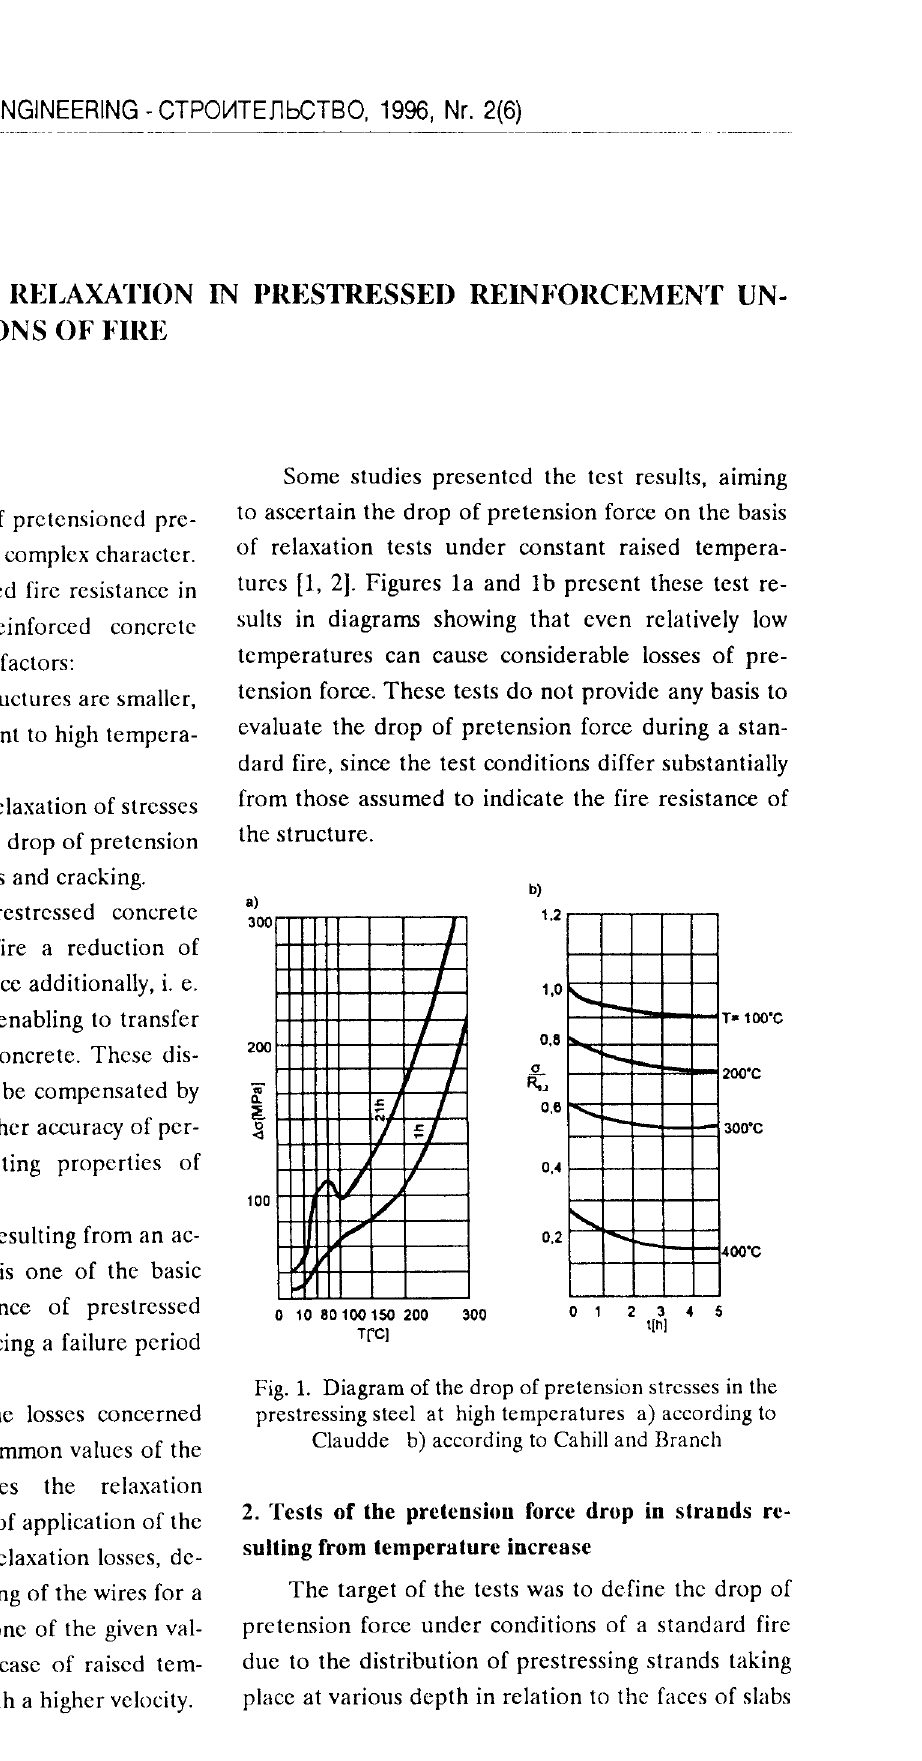
Fig. 1. Diagram of the drop of pretension stresses in the prestressing steel at high temperatures a) according to Claudde b) according to Cahill and